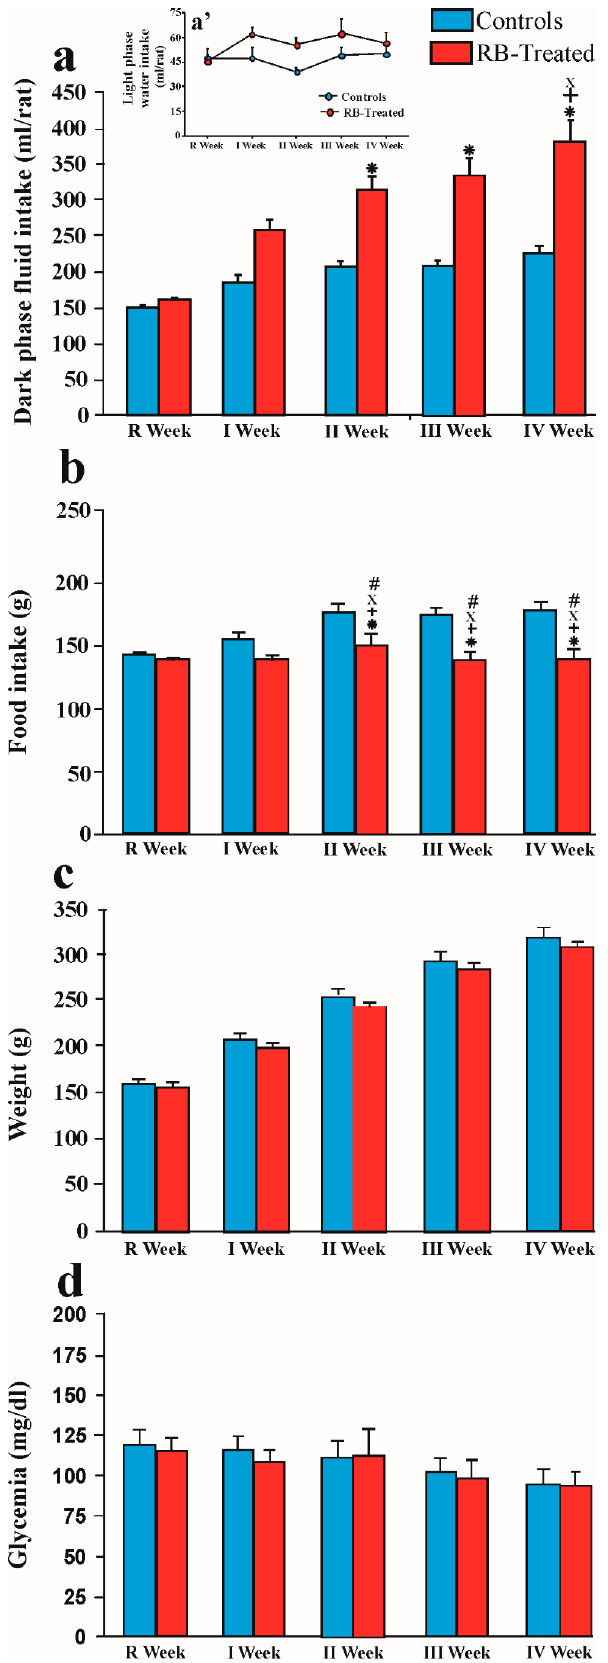
Figure 1. Consummatory and metabolic data during the R week and the 4 weeks of treatment. ( a )